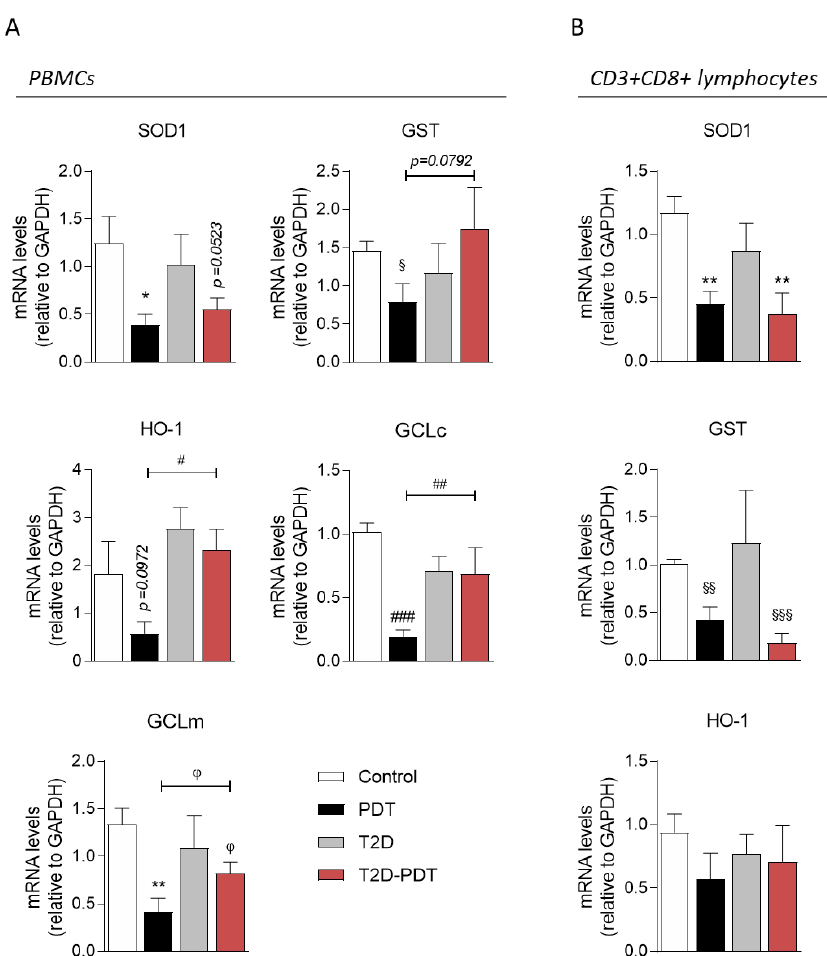
Figure 4. mRNA levels of Nrf2 target genes in PBMCs and CD3+CD8+ lymphocytes. Relative expression of ( A ) SOD1, GST, HO-1, GCLc, and GCLm mRNA in PBMCs or ( B ) SOD1, GST, and HO-1 in CD3+CD8+ lymphocytes, from control individuals, PDT, T2D, and T2D-PDT patients